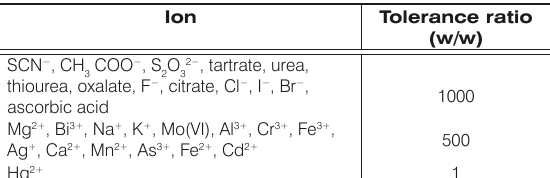
Figure 3. Plot of PRESS against the number of factors for Cu(II), Ni(II) and Co(II) Table 4. Tolerance ratio of diverse ions on the determination of a mixture of 0.5 μg mL −1 Co(II), Cu(II) and Ni(II)